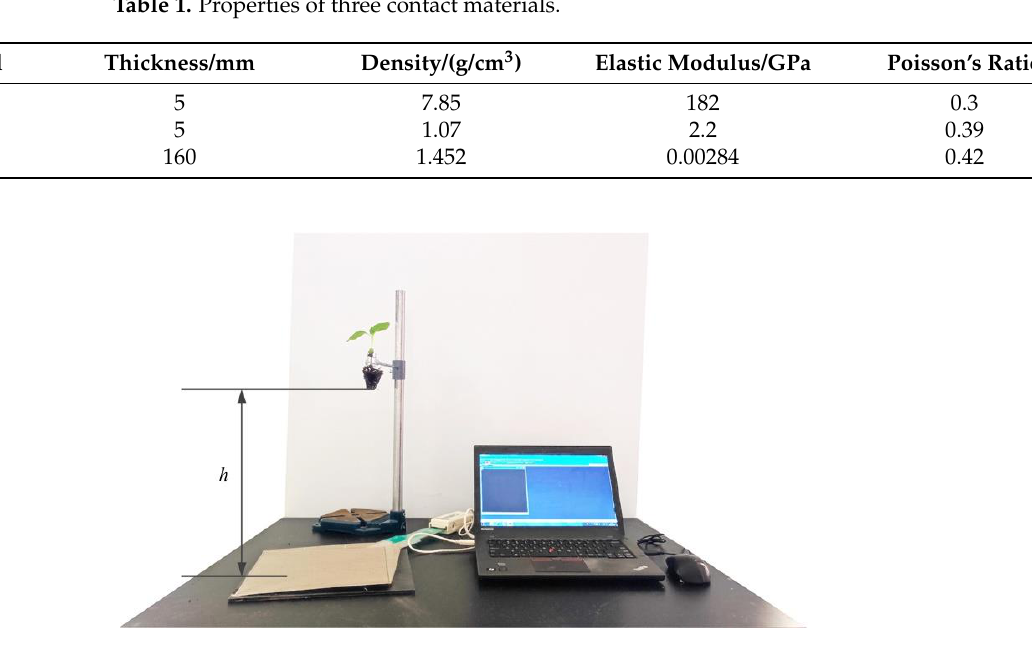
Figure 4. Position of the plug seedlings with steel plates before dropping. Table 1. Properties of three contact materials.